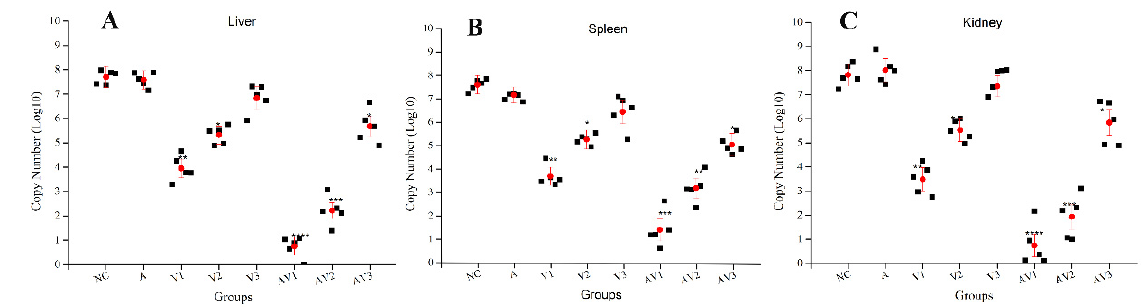
Figure 4. Determination of TiLV viral load from different tissues after challenge with a virulent TiLV isolate: ( A ) TiLV load in liver, ( B ) TiLV load in spleen, and ( C ) TiLV load in kidney. Data are presented as the mean ± SD. A comparison between the vaccinated groups V1, V2, V3, VA1, VA2, and VA3 with the NC or A groups is shown. The different numbers of asterisks indicate significant differences in viral load levels at p < 0.05.